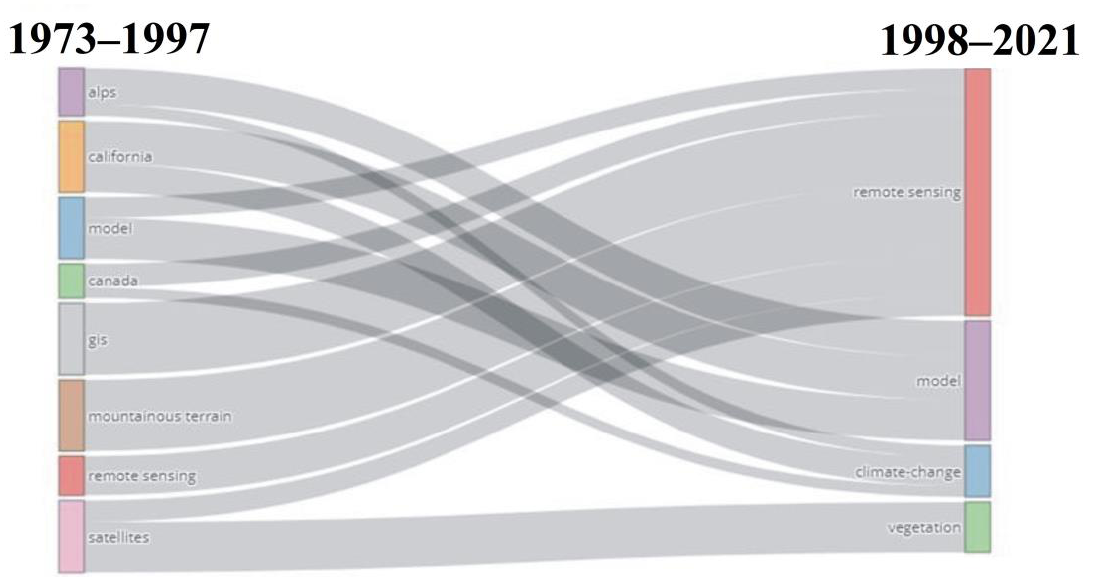
Figure 6. Thematic evolution of keywords from 1973 to 2021 for the publications used in this study.